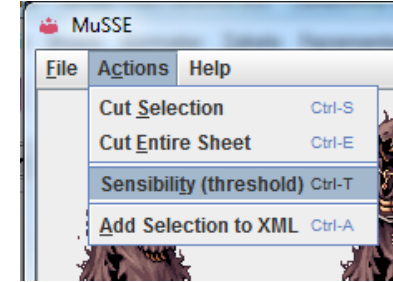
Fig. 19. Sprite sheet with low connectivity (close-up). Source: MuSSE with sprite sheet image from the game Ragnarok Online©. As pointed out before, smaller thresholds for our connected-component method will result in a higher number of blobs in the selected image, as seen in Fig. 19. That problem can be solved by selecting a more suitable threshold for the sheet. The user can choose a specific threshold for the Blob detection algorithm in MuSSE by selecting the option “Sensibility (threshold)” from the “Actions” menu (Fig. 20).